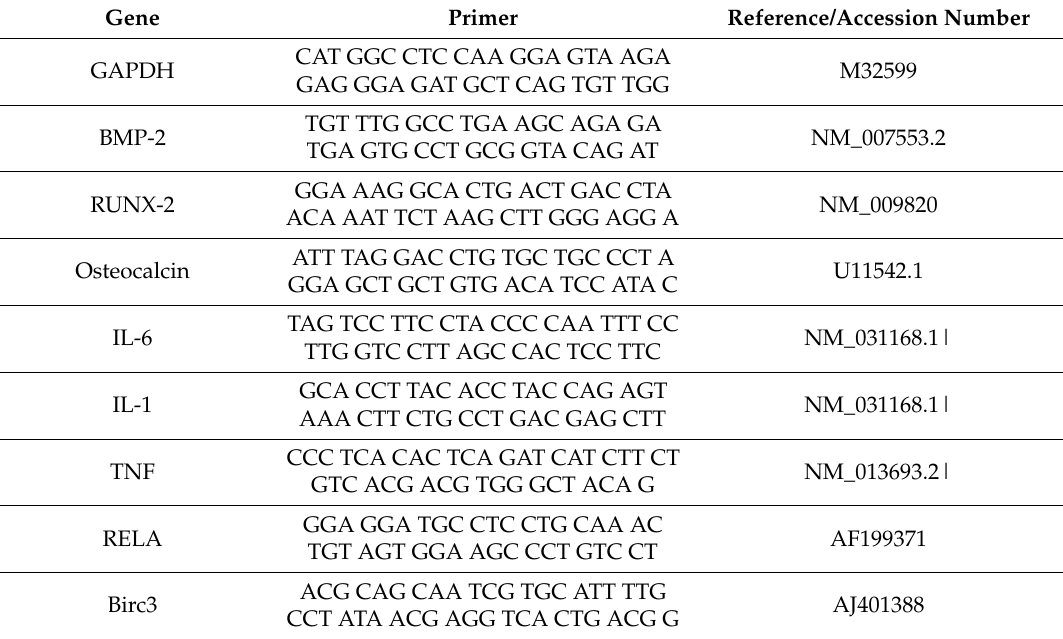
(Table 1). Glyceraldehyde-3-phosphate dehydrogenase (GAPDH) was used as the internal control for normalization. Table 1. Nucleotide sequences of mouse primers used for RT-PCR. Gene